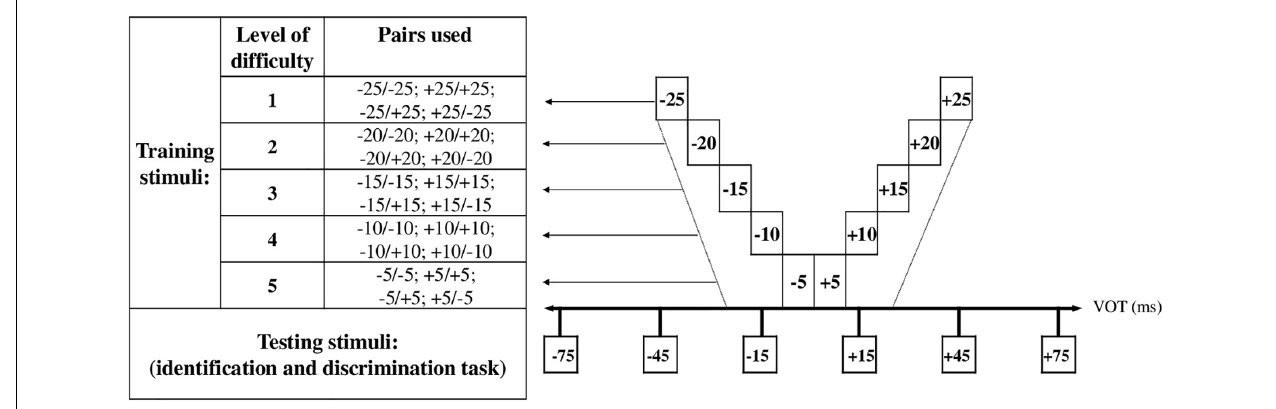
FIGURE 2 | VOT values used in RapDys© for the identification and discrimination tasks (from Collet et al., 2012, Figure 1).